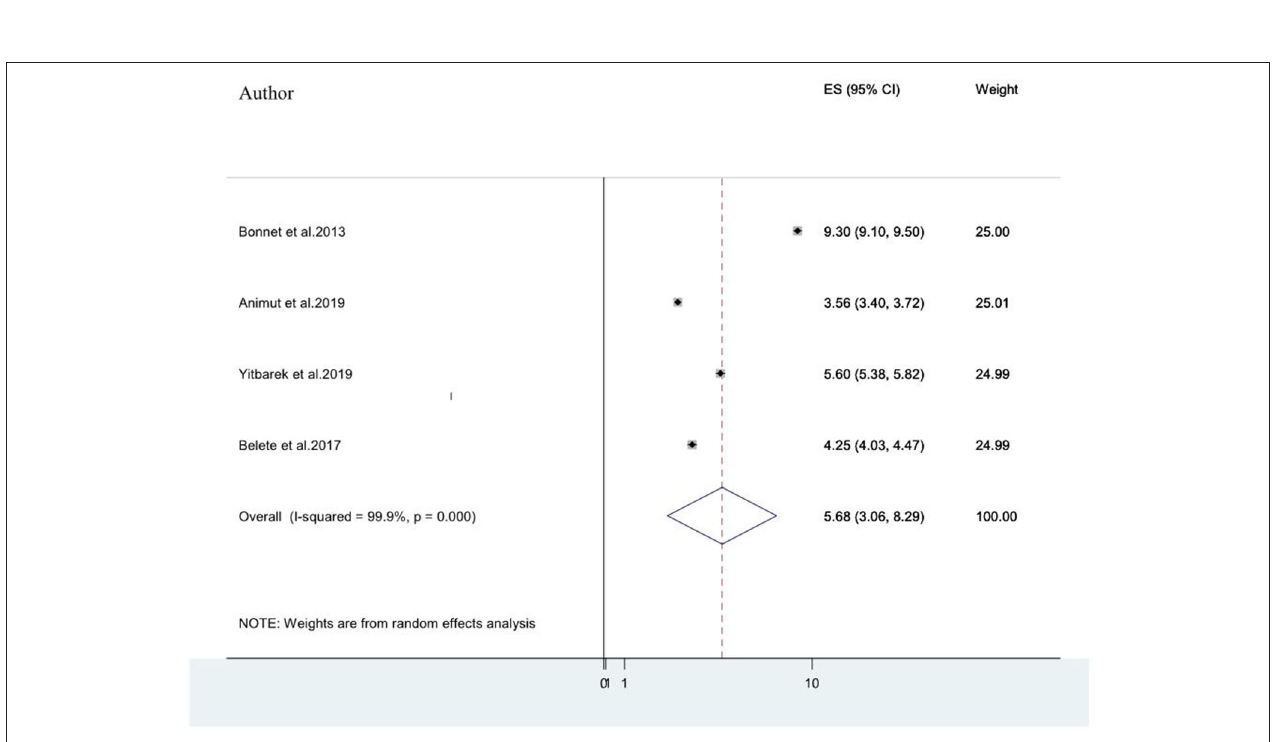
FIGURE 8 | A forest plot for the pooled odds ratio of associated between advanced stage of AIDS and HIV-associated neurocognitive disorder.